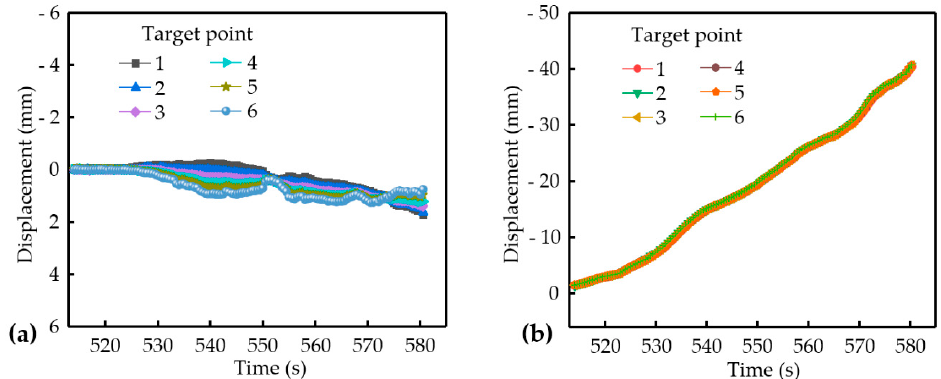
Figure 4. The displacement–time curves: ( a ) horizontal displacement; ( b ) vertical displacement.